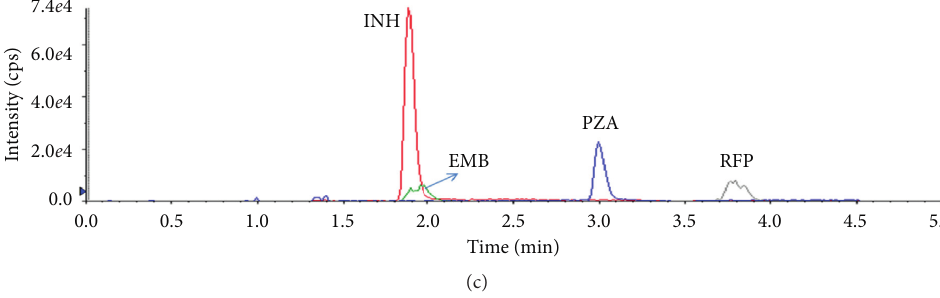
Figure 5: Chromatograms of the selected columns: (a) XSelecT HSS T3 column; (b) Waters XBridge Shield RP18 column; (c) Agilent Zorbax